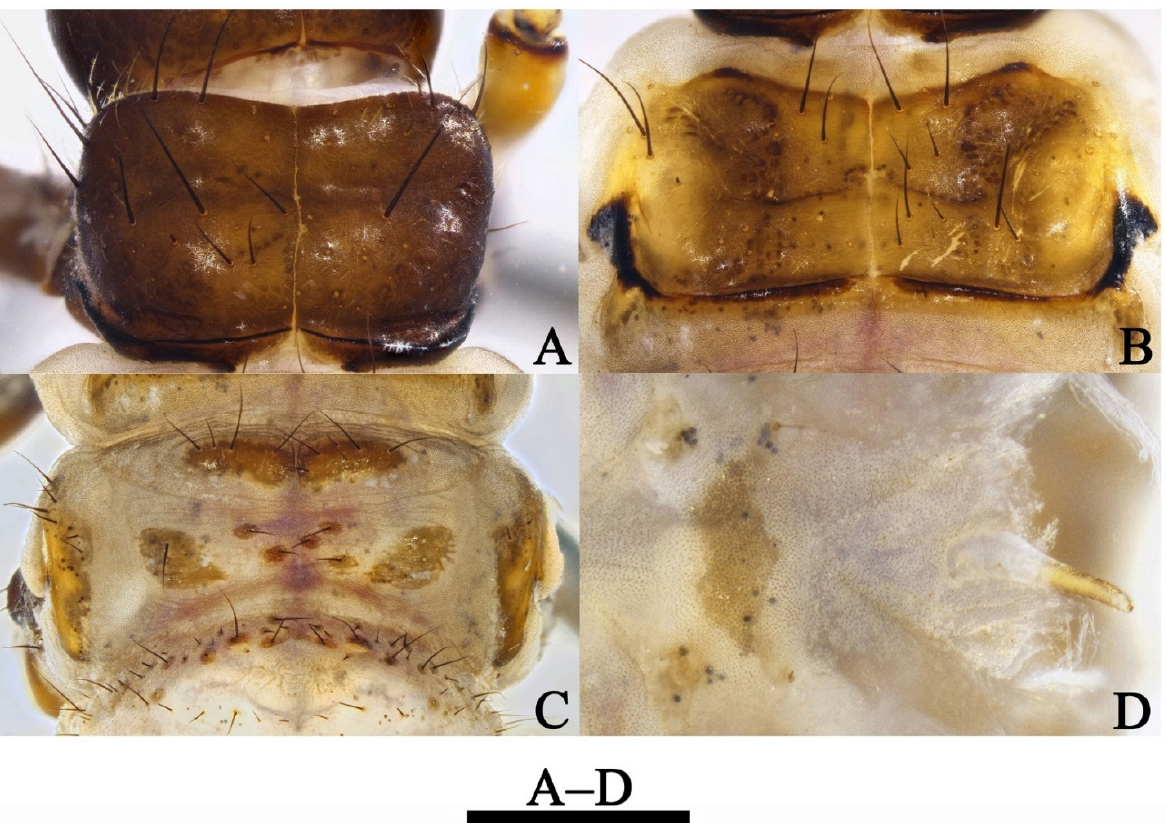
Figure 9. Limnephilus deqianensis n. sp. , larval thorax. ( A ) Pronotum; ( B ) mesonotum; ( C ) metanotum; ( D ) prosternites and prosternal horn. Scale bar: 1 mm.